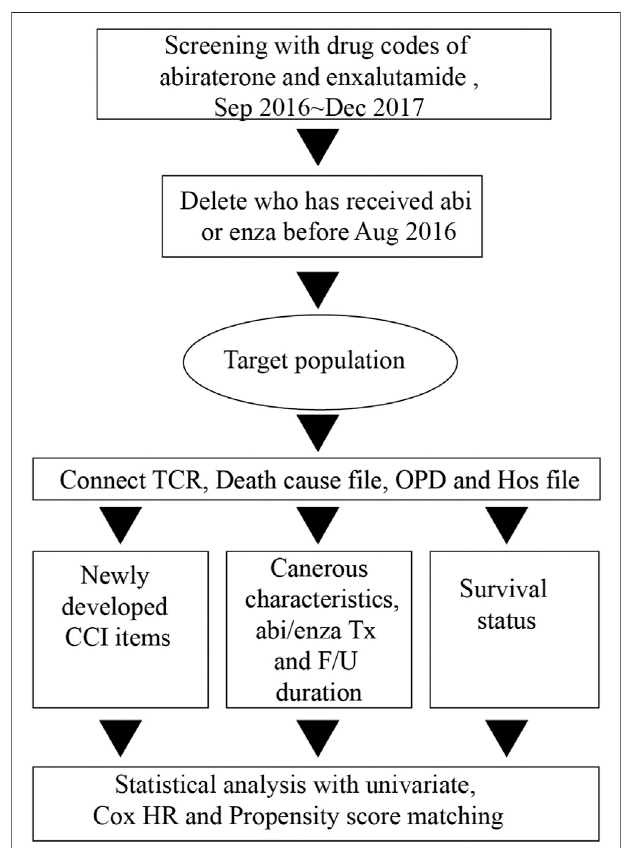
FIGURE 1 | Flowchart of subject enrollment and data